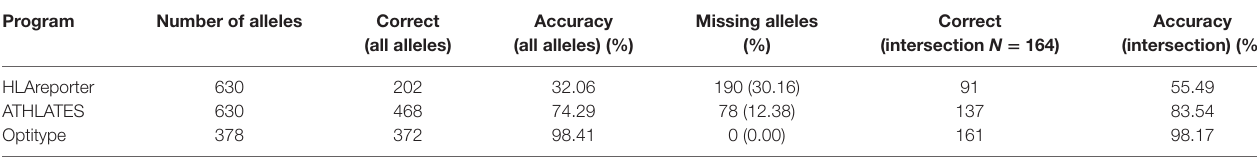
TaBle 3 | Summary of accuracies of the human leukocyte antigen (HLA) interpretation programs for 1000 Genomes